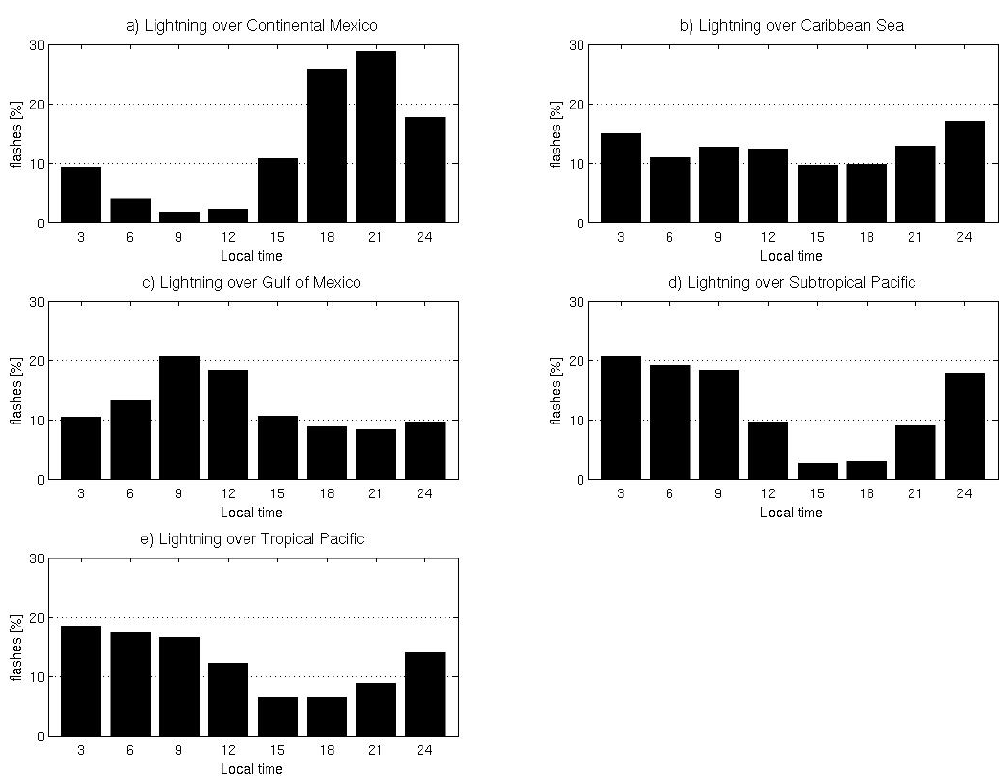
Fig. 7. Average diurnal cycle for the total number of cloud-to-ground strokes in percentage for (a) continental Mexico, (b) Caribbean Sea, (c) Gulf of Mexico, (d) Subtropical Pacific and e) Tropical Pacific. The three-hour lightning accumulates are centred at the hours indicated in the